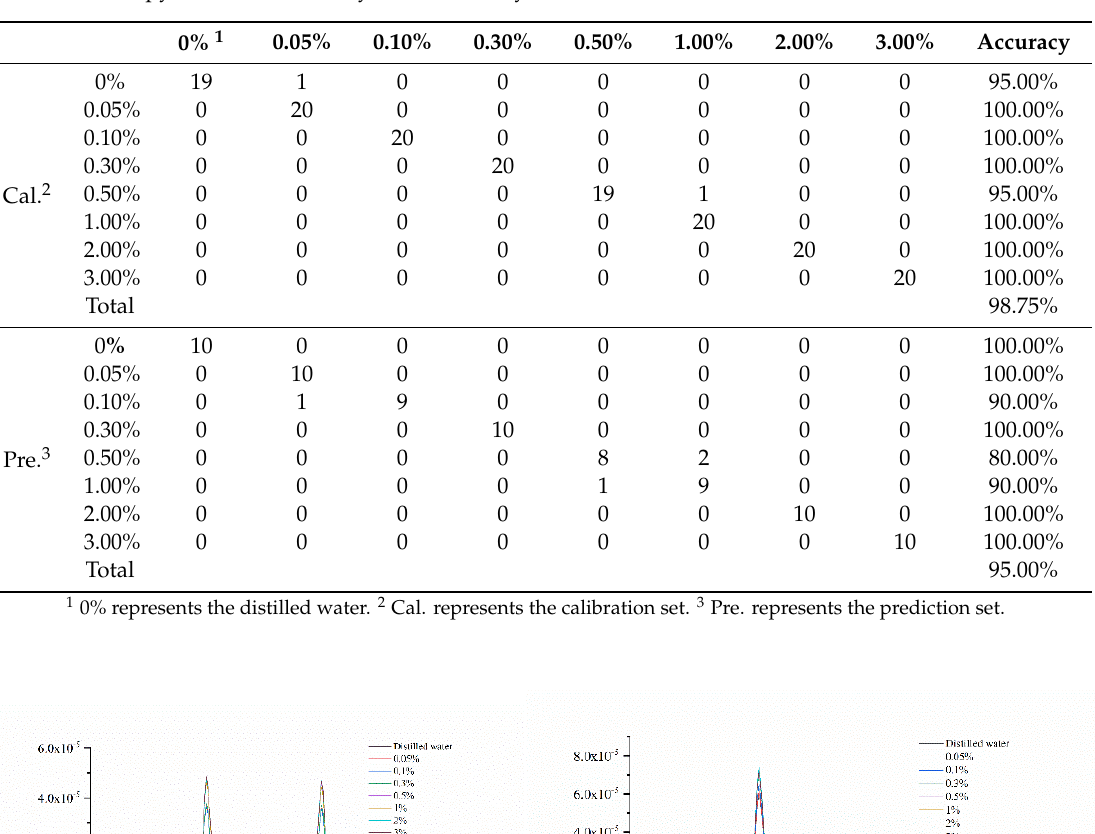
Table 2. Confusion matrix of support vector machine (SVM) model based on full spectra for classification the sulfur dioxide residues on the surface of fresh-cut potato slices immersed in di ff erent concentrations of sodium pyrosulfite solution by the NIR-HSI system.